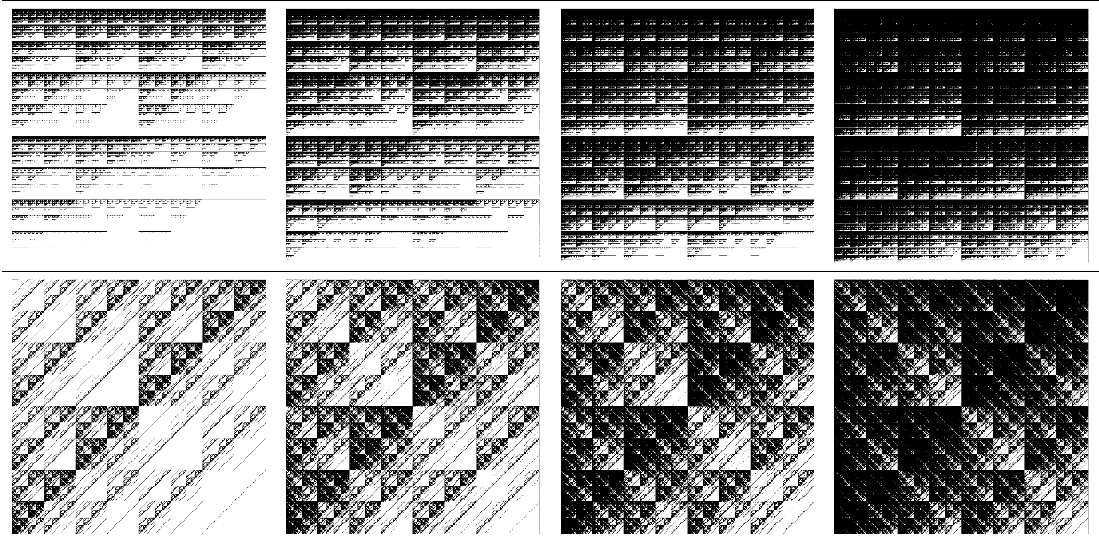
Figure 6. Binarized images of configurations M5 (upper-row) and M6 (lower-row) at different thresholds t . Columns from left to right: t = 0.2, t = 0.4, t = 0.6, t = 0.8.